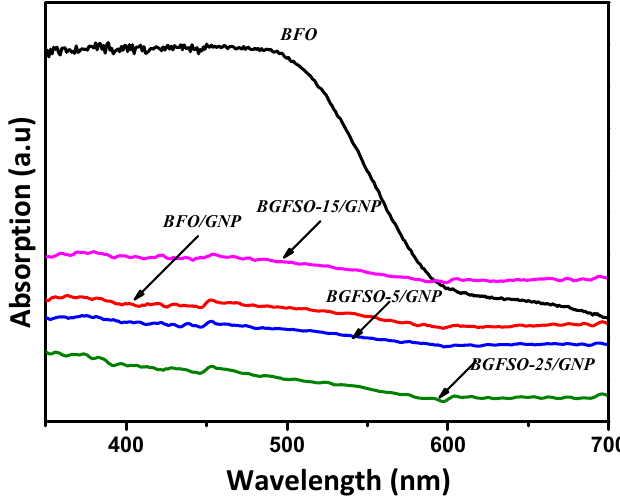
Figure 5. UV-vis absorption spectra (DRS spectra) of BFO, BFO/GNP and BGFSO/GNP nanohybrids.